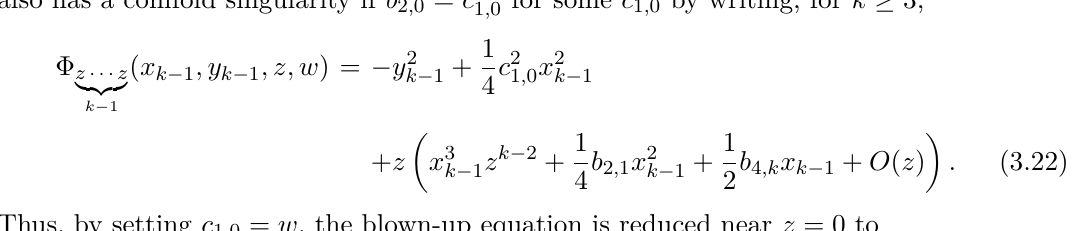
JHEP10(2022)070